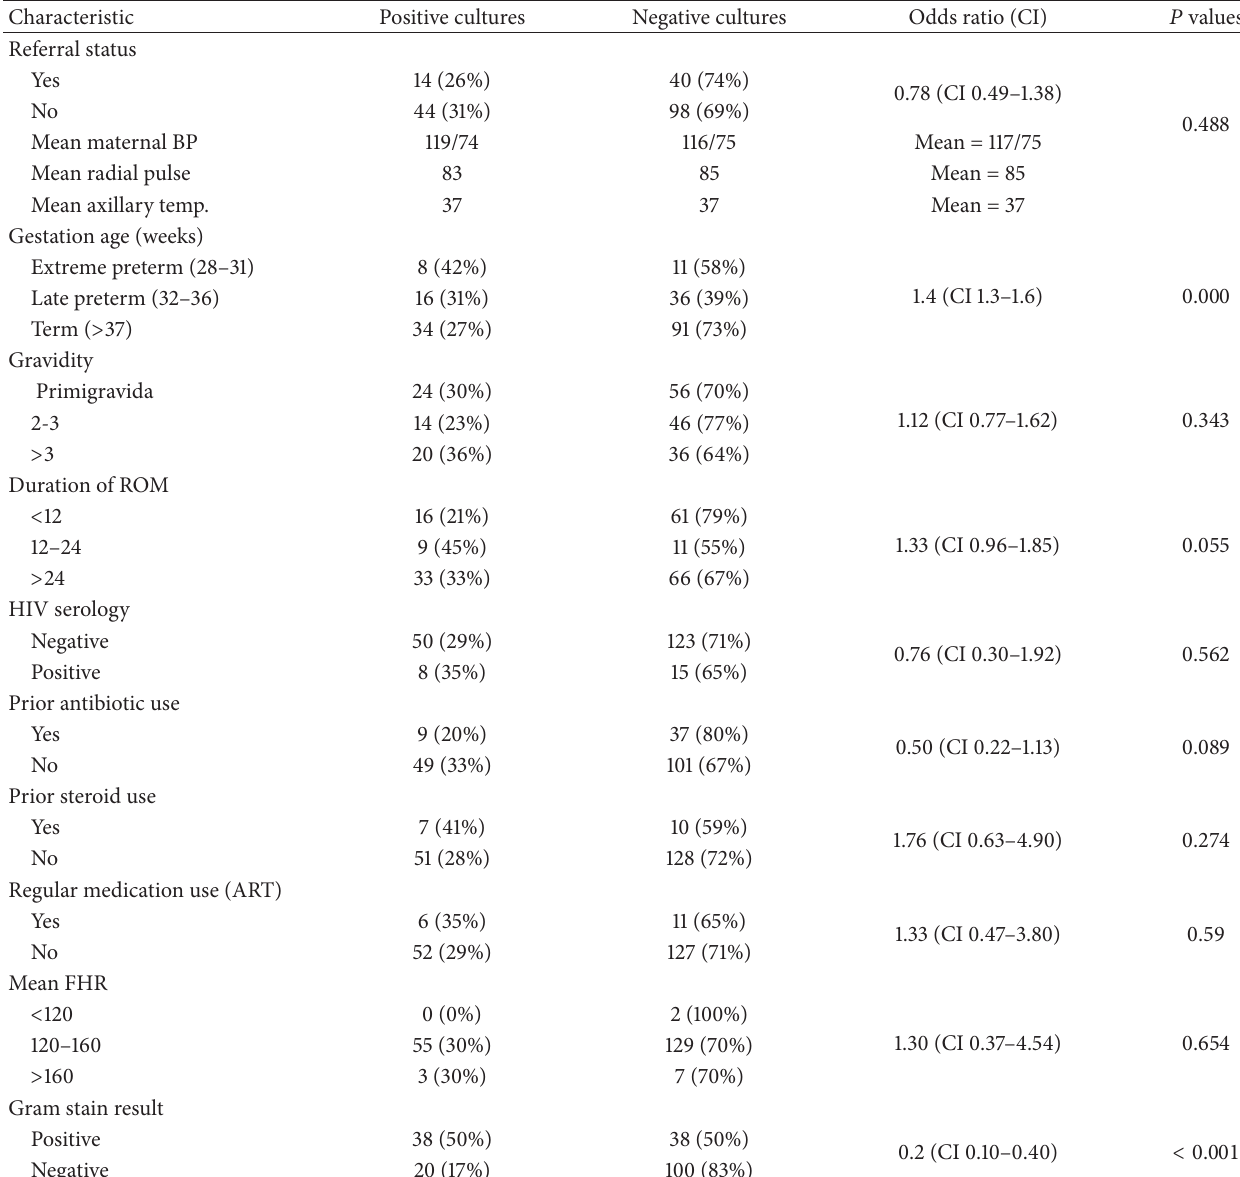
Table 4: Factors associated with cervicovaginal culture and sensitivity